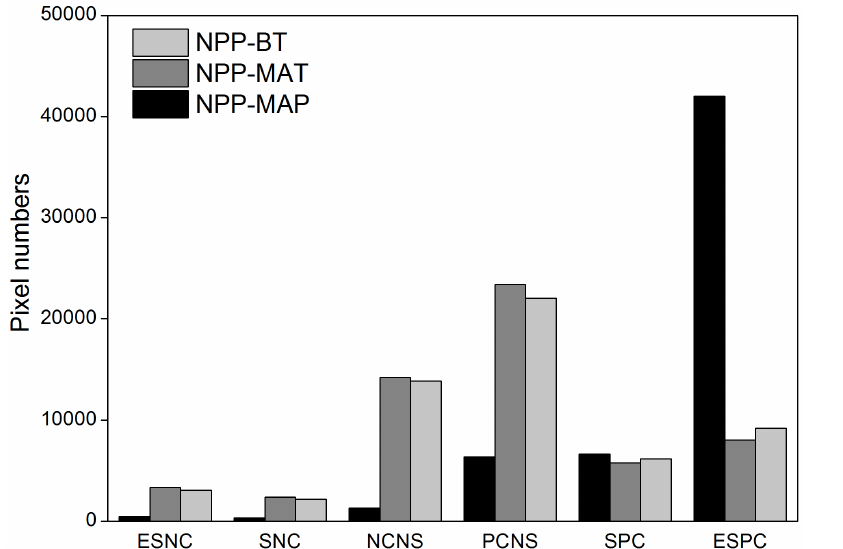
Figure 6. Proportion of different correlations between global NPP and MAP, MAT and BT. ESNC is extremely significant negative correlation; SNC is significant negative correlation; NCNS is negative correlation but none significant; PCNS is positive correlation but none significant; SPC is significant positive correlation; ESPC is extremely significant positive correlation.